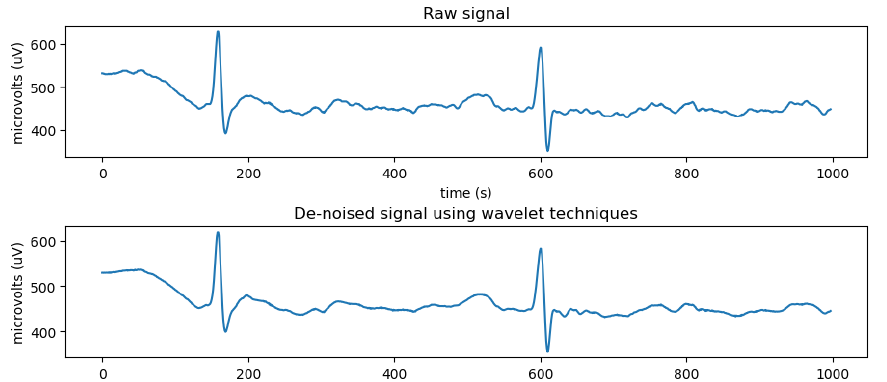
Figure 2. ECG signal through wavelet